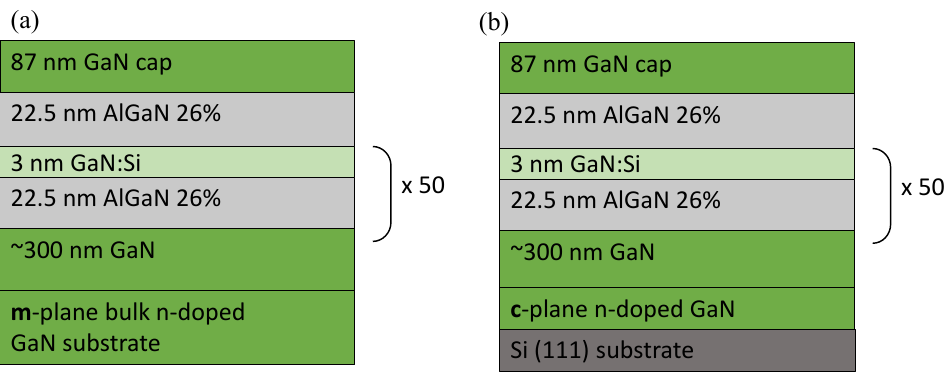
Figure 1. The scheme of the ( a ) non-polar and ( b ) polar GaN/AlGaN MQW structures. The structural characterization was performed by high-resolution X-ray diffraction (HRXRD) and high-resolution (scanning) transmission electron microscopy [(S)TEM]. HRXRD measurements were performed with a Panalytical X’Pert Pro MRD X-ray diffrac- tometer, operating at the Cu_Kα 1 wavelength, and equipped with a hybrid two-bounce tional or Pixcel). For each sample, two types of measurements were performed: a /2Θ